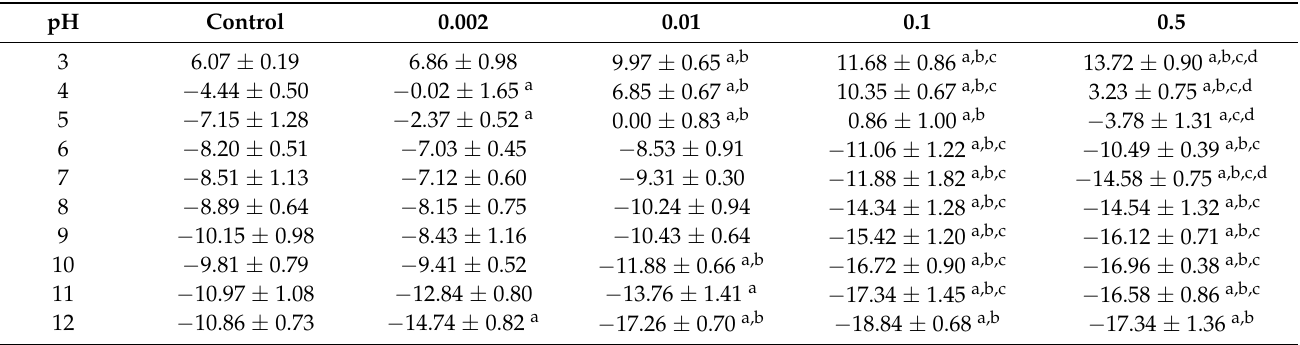
Table 2. The zeta potential of the erythrocytes’ cell membranes after exposure to PS-NH 2 -200 (C = 0.002, 0.01, 0.1, and 0.5